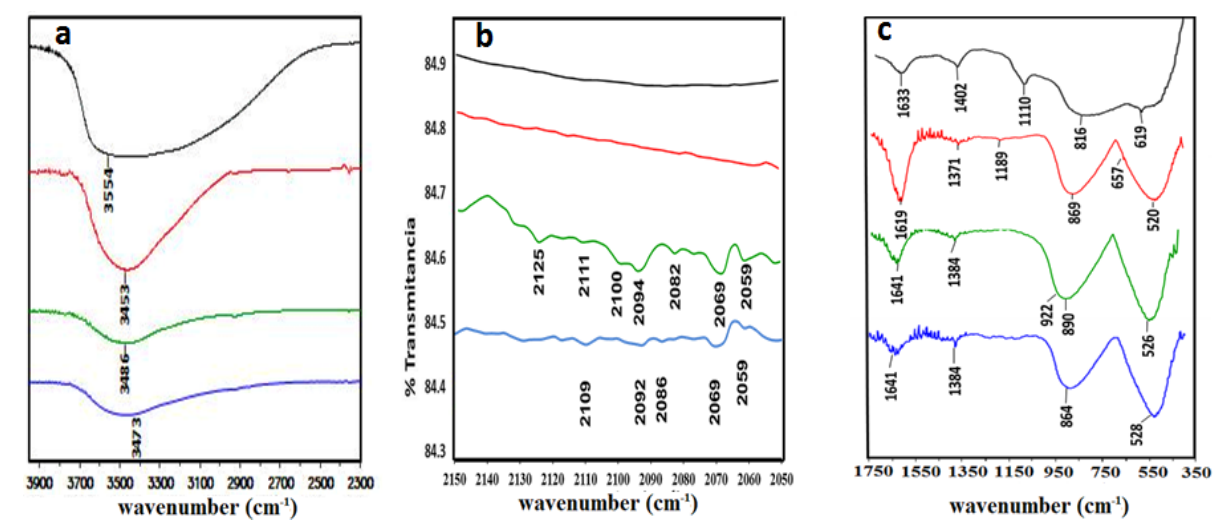
Figure 3. FT-IR spectra in the ( a ) 2300–3900 cm −1 ; ( b ) 2050–2150 cm −1 and ( c ) 350–1750 cm −1 : regions for the alumina (—), Fe/Al and Pt-Fe/Al O 0.5%-0.5% (—) 2 3